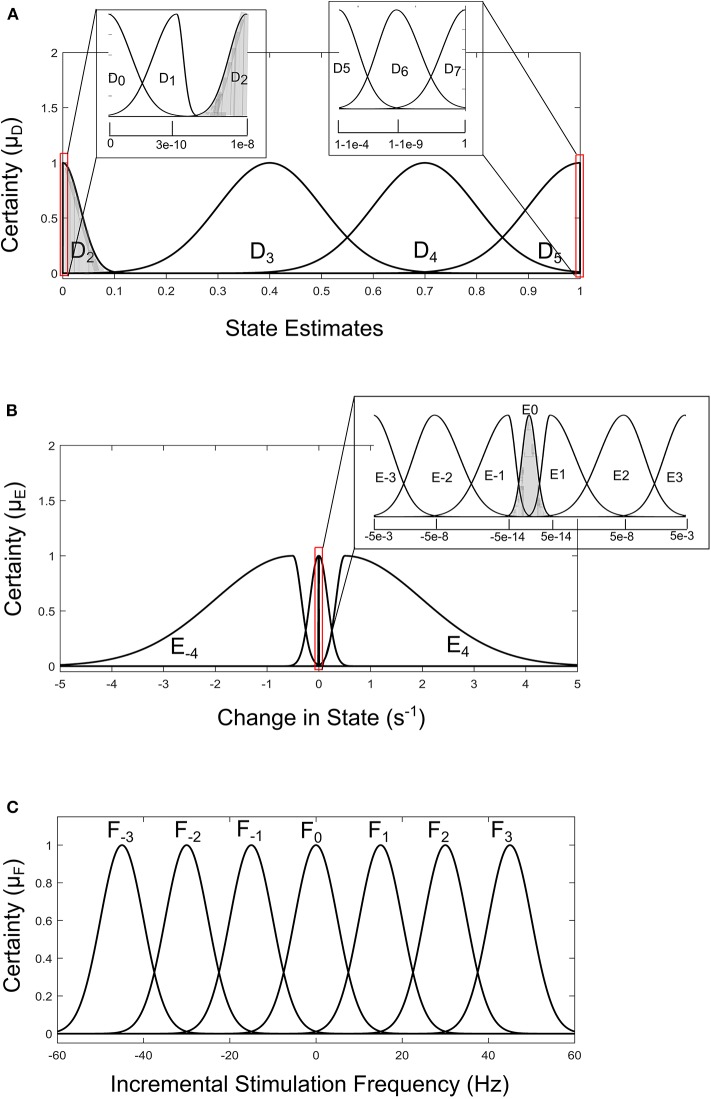
Input-output membership functions for the fuzzy controller driven by GMM state estimates. (A) Membership functions for the state estimates. (B) Membership functions for the rate of change in state. (C) Membership function for the incremental stimulation frequency.